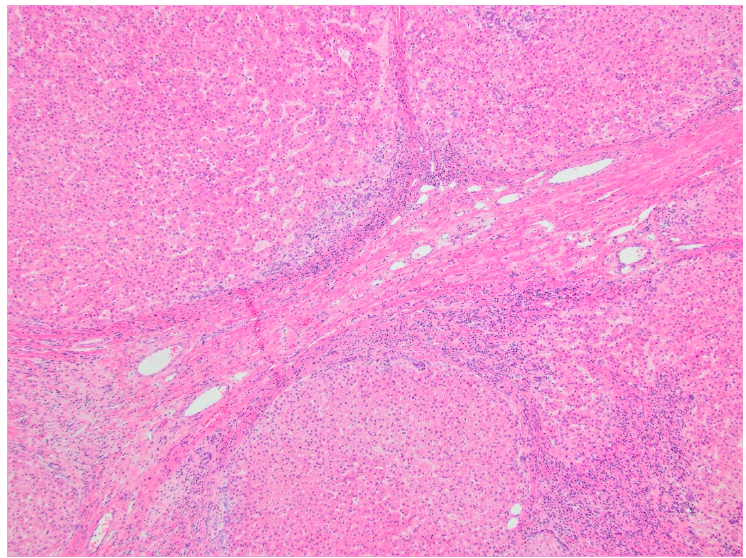
Figure 9. Focal nodular hyperplasia (H&E, 4× magnification). Nodular hepatic parenchyma with bile ductular proliferation and central scar containing abnormal blood vessels.